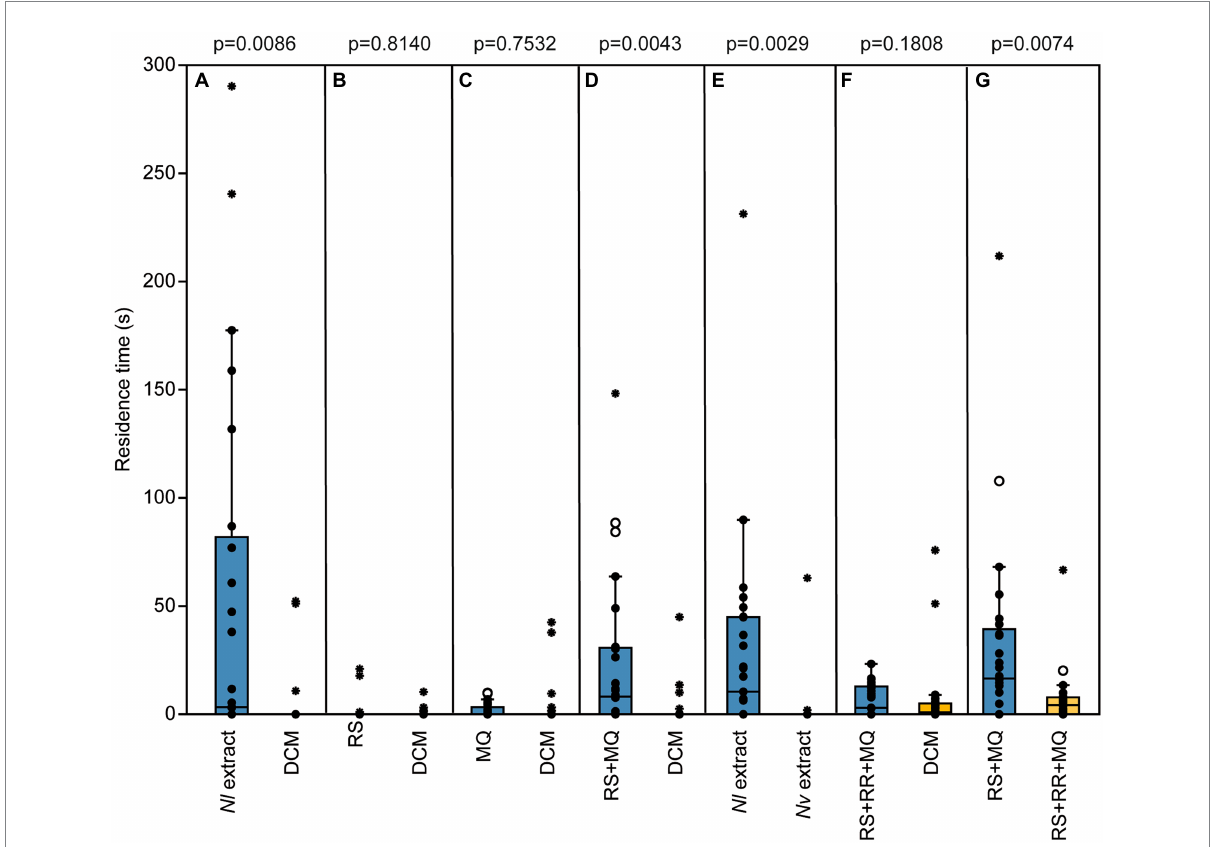
FIGURE 3 The male sex pheromone attracts virgin Nasonia longicornis ( Nl ) females species-specifically. Residence time of virgin Nl females in the two odor fields of a static two-choice olfactometer when given the choice between dichloromethane (DCM, control) and (A) one male equivalent of a natural Nl pheromone extract, (B) 200 ng of synthetic (4 R ,5 S )-5-hydroxy-4-decanolide (RS), (C) 0.5 ng of synthetic 4-methylquinazoline (MQ), (D) the synthetic pheromone blend of Nl males (200 ng RS + 0.5 ng MQ), and (F) the synthetic pheromone blend of N. vitripennis ( Nv ) males (200 ng RS + 0.5 ng MQ + 100 ng (4 R ,5 R )-5-hydroxy-4-decanolide (RR)). Furthermore, virgin females were given direct choice between (E) natural pheromone extracts from Nl and Nv males and (G) the synthetic pheromone blends of Nl and Nv males [treatments (D) and (E) ]. Box and whisker plots show median (horizontal line), 25%–75% quartiles (box), maximum/minimum range (whiskers) and outliers ( ° >1.5 × above box height; *>3 × above box height; n = 25, data analysis by a Wilcoxon matched-pairs